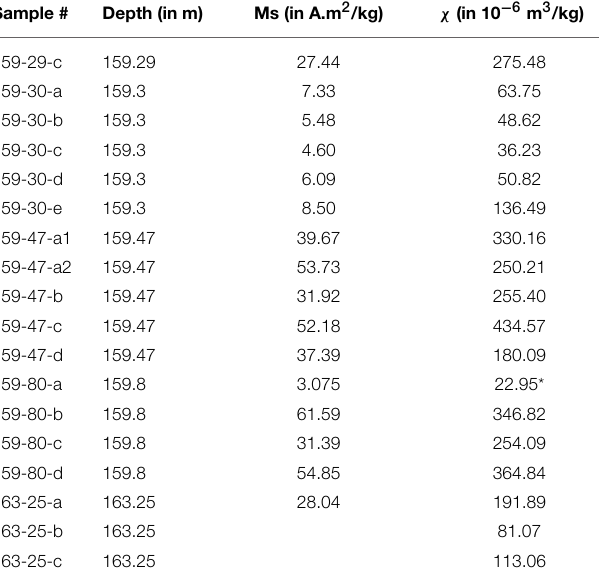
TABLE 2 | Saturation magnetization Ms and susceptibility χ data for TCDP-1 from 130.45 to 163.25m depth, susceptibility results are obtained using the KLY-3 except data with * obtained using the